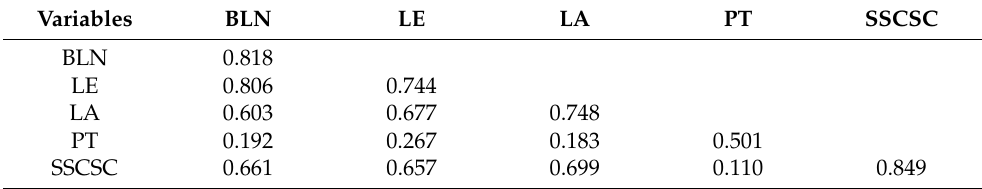
Table 4. Results of the discriminant validity